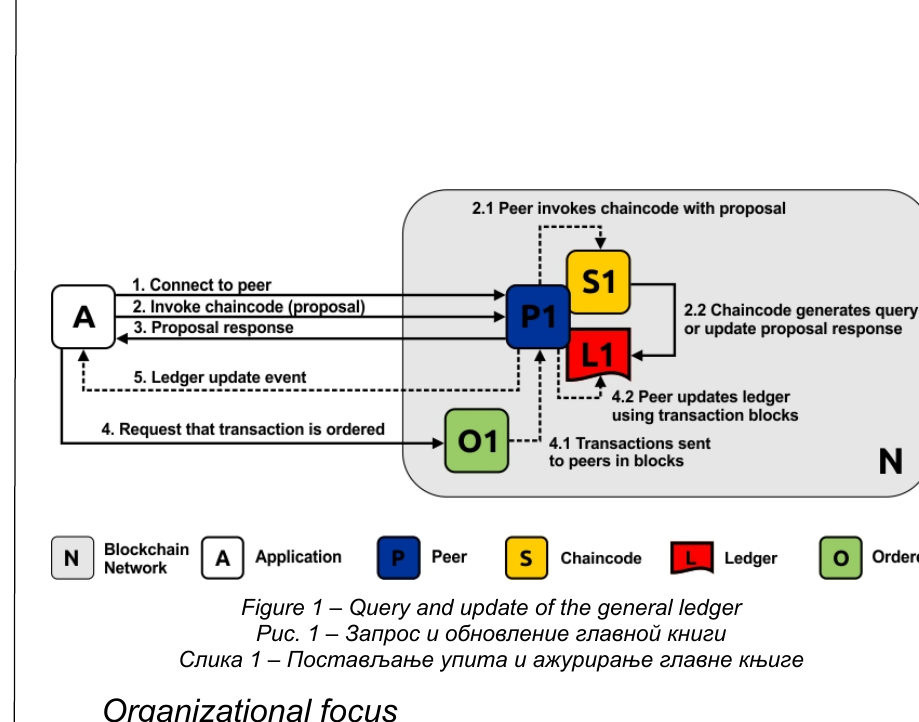
Figure 1 – Query and update of the general ledger Рис . 1 – Запрос и обновление главной